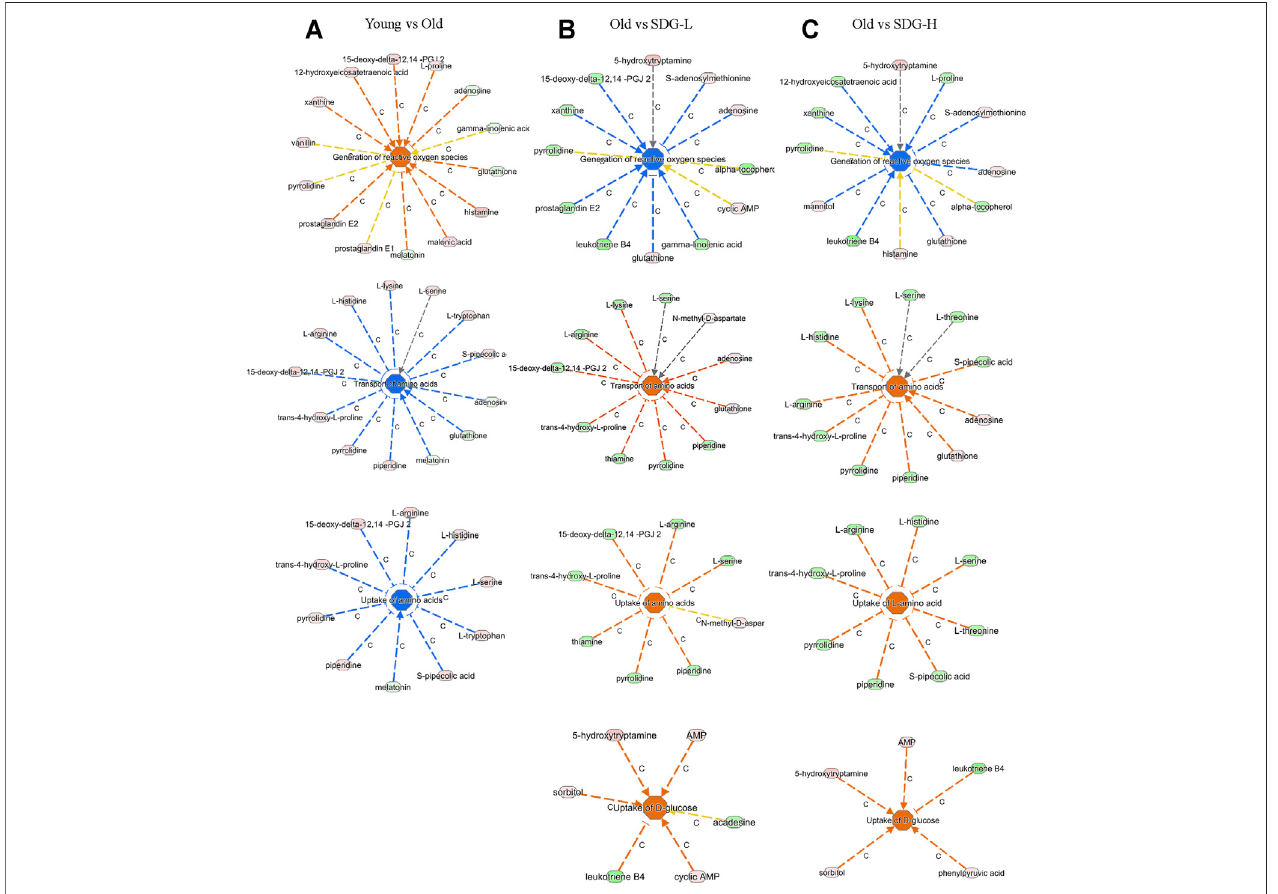
FIGURE 5 | The related differential metabolites in each Disease or Functions Annotation by IPA in different groups. The comparisons ofthe Young and the Old (A) , the Old and the SDG-L (B) , and the Old and the SDG-H (C) are shown. The disease states and biological functions are in the center; blue represents a decrease and orange represents an increase. The metabolites in light green represent a quantitative decrease, while in pink represent an increase. The lines between the annotation and the metabolites represent the predicted relationship. The line in blue leads to inhibition, the line in orange leads to activation, the line in yellow represents the fi ndings is inconsistent with the state of downstream molecule, and the line in grey represents the effect not predicted.